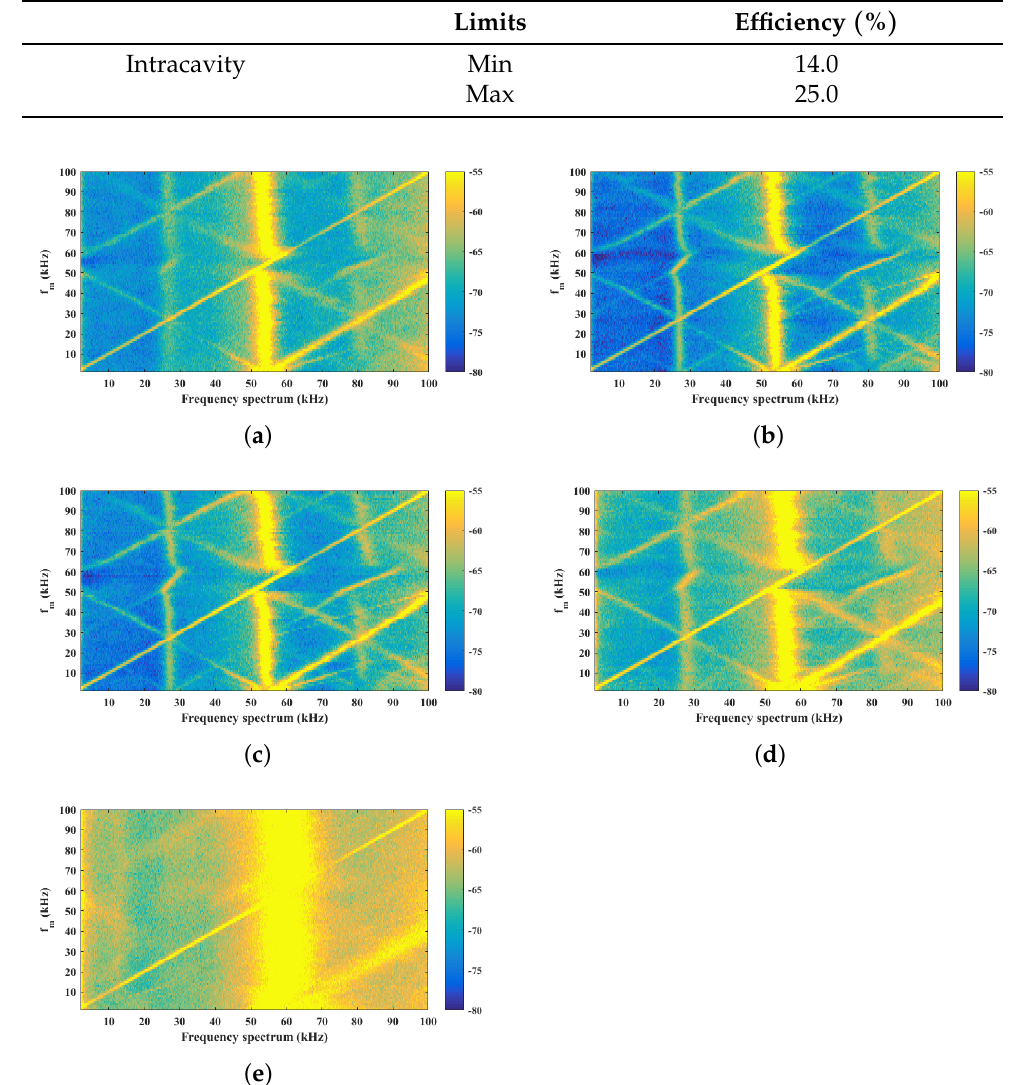
Figure 10. Frequency spectrum maps obtained by varying harmonic modulation frequency 1 kHz < f m < 100 kHz and modulation amplitude: ( a ) A m = 2 V; ( b ) A m = 4 V; ( c ) A m = 6 V; ( d ) A m = 8 V; ( e ) A m = 10